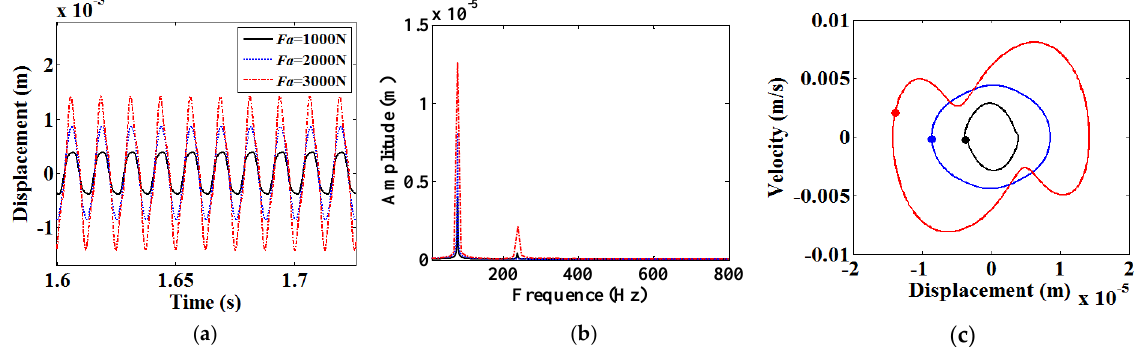
Figure 11. Vibration responses at ω = 500 rad/s: ( a ) Time history; ( b ) Spectrum; ( c ) Phase diagram and Poincaré section.